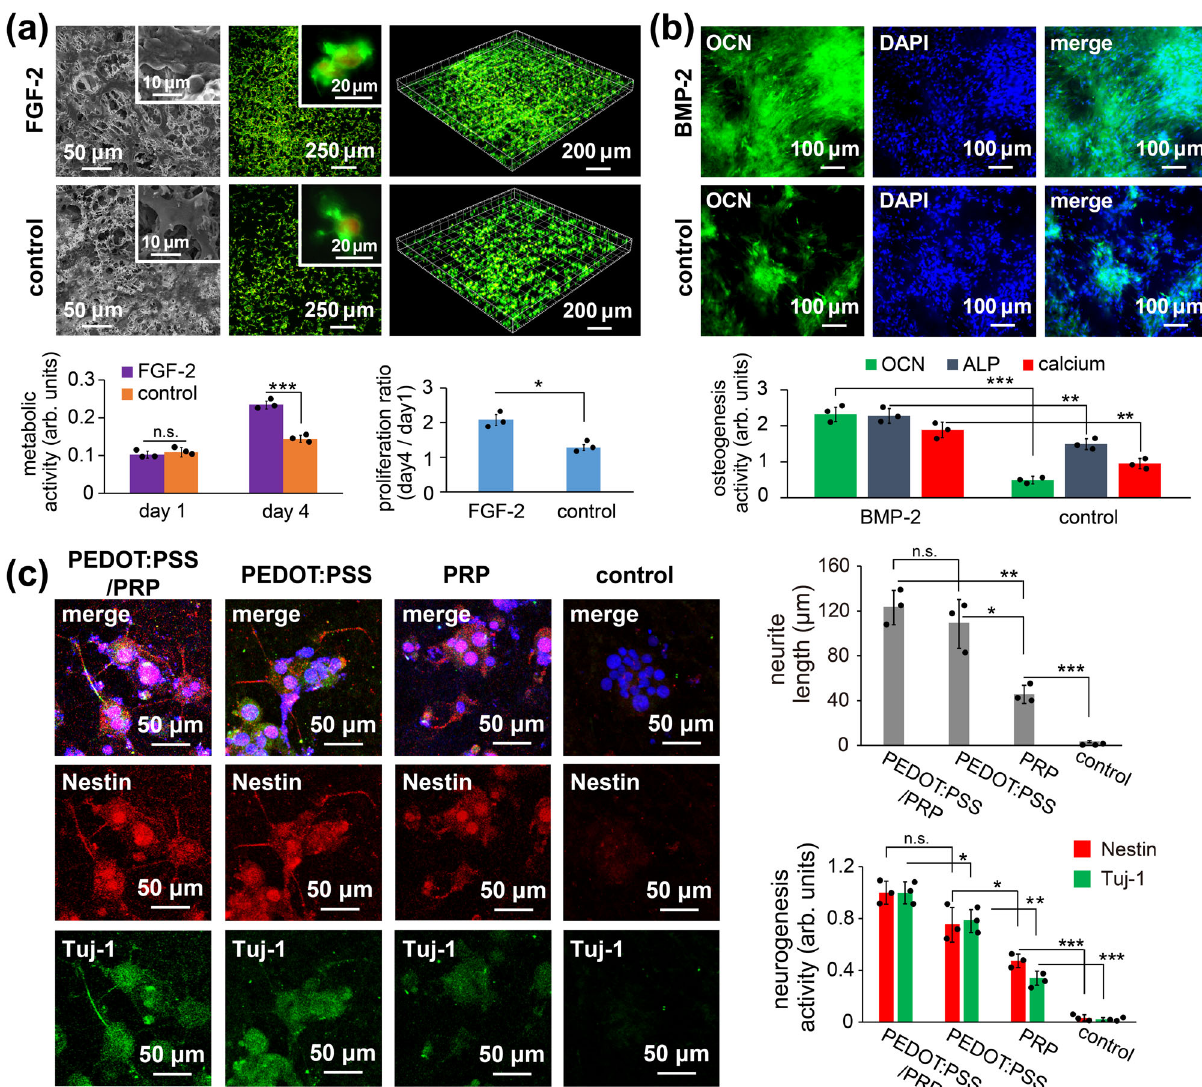
Fig. 2 Fabrication of various modules with speci fi ed cell-guiding activities. a SEM and laser confocal images were recorded for modules containing hASCs cells and FGF-2 and showed cell proliferation activities after culturing for 4 days. The F-actin cytoskeleton (green) was stained by Alexa Fluor ® 488- conjugated phalloidin and the nucleus (red) was stained with propidium iodide; the inset images showed attached and spread cells ( n = 3 independent samples; mean ± SD; unpaired t test; bottom left panel: FGF-2 vs. control at day 1 n.s., nonsigni fi cant difference p = 0.7217 > 0.05, FGF-2 vs. control at day 4 *** p = 0.0006 < 0.001; bottom right panel: FGF-2 vs. control * p = 0.0116 < 0.05). b Modules composed of MC3T3-E1 cells and BMP-2 showed guided osteogenesis activities. The ALP expression was analyzed after 7 days of culture, whereas OCN expression and calcium deposition were analyzed after 21 days of culture ( n = 3 independent samples; mean ± SD; unpaired t test; bottom panel: BMP-2 vs. control from OCN *** p = 0.0002 < 0.001, BMP-2 vs. control from ALP ** p = 0.0056 < 0.01, BMP-2 vs. control from calcium ** p = 0.0033 < 0.01). c Modules composed of more complex components, including PC12 cells, PRP molecules, and the PEDOT:PSS system, were fabricated and showed guided neurogenesis activities after 5 days of culture ( n = 3 independent samples; mean ± SD; unpaired t test; top panel: PEDOT:PSS/PRP vs. PEDOT:PSS n.s. p = 0.3915 > 0.05, PEDOT:PSS/PRP vs. PRP ** p = 0.0014 < 0.01, PEDOT:PSS vs. PRP * p = 0.0103 < 0.05, PRP vs. control *** p = 0.0009 < 0.001; bottom panel: PEDOT:PSS/PRP vs. PEDOT:PSS from Nestin n.s. p = 0.0617> 0.05, PEDOT:PSS/PRP vs. PEDOT:PSS from Tuj-1 * p = 0.0452< 0.05, PEDOT:PSS vs. PRP from Nestin * p = 0.0295< 0.05, PEDOT:PSS vs. PRP from Tuj-1 ** p = 0.0019 < 0.01, PRP vs. control from Nestin *** p = 0.0008 < 0.001, PRP vs. control from Tuj-1 *** p = 0.0008 <